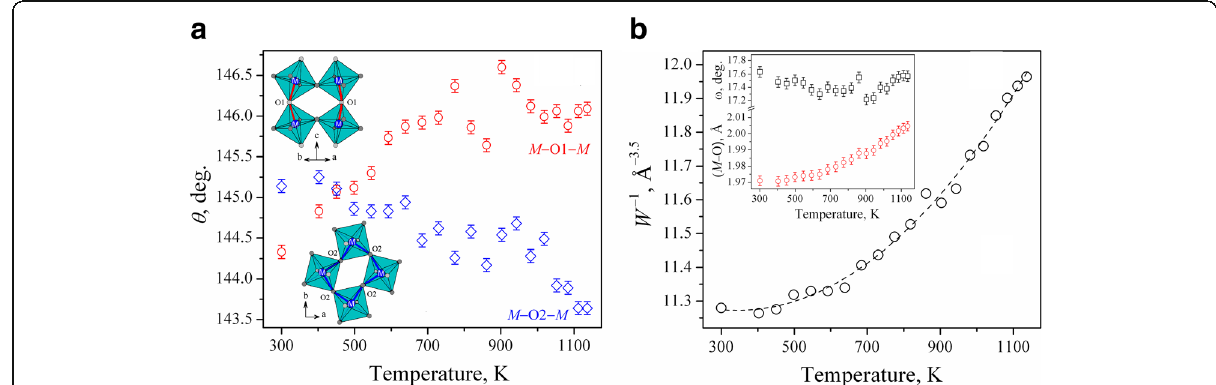
Fig. 5 Temperature evolution of the M – O – M angles ( a ) and inverse bandwidth W − 1 ( b ) in HoCo 0.5 Cr 0.5 O 3 structure. Inset shows thermal behaviour of the average bong length M – O and octahedral tilt angles